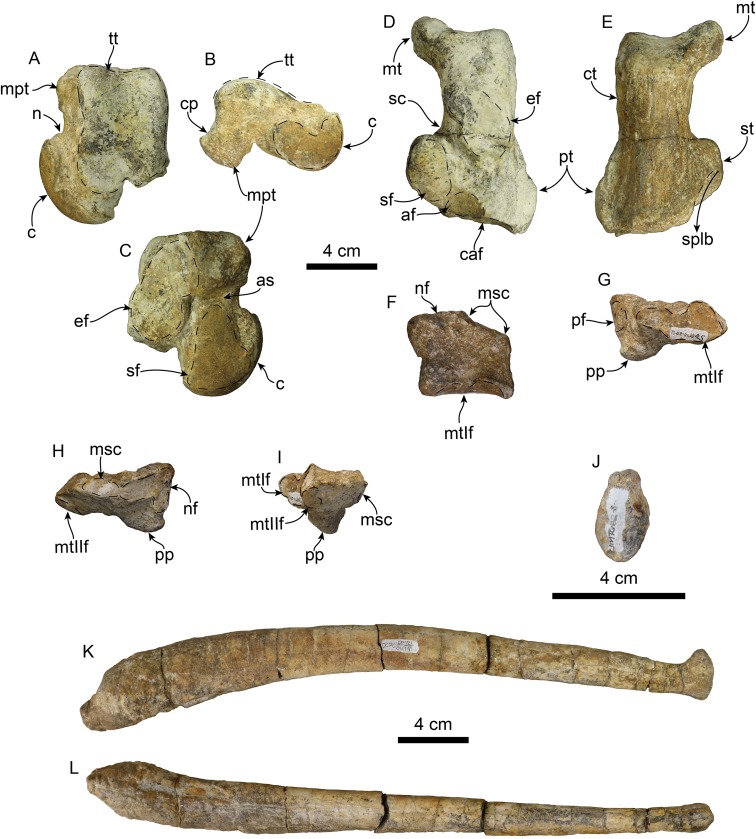
Hindlimb elements and baculum of Titanotaria orangensis n. gen. et sp. (OCPC 11141).Left astragualus in tibial (A), medial (B), and ventral (C) views; left calcaneum in dorsal (D), and plantar (E) views; left entocuneiform in dorsal (F), distal (G), proximal (H), and lateral (I), views; baculum in proximal (J), right lateral (I), and ventral (L) views. Abbreviations: af, accessory facet; astragalar sulcus; c, capitulum; caf, cuboid articular facet; cp, calcaneal process; ct, calcaneal tuber; ef, ectal facet; mpt, medial plantar tuberosity; msc, mesocuneiform facet; mt, medial tuberosity; mtIf, metatarsal I facet; n, neck; nf, navicular facet; pf, pisiform facet; pp, plantar process; pt, peroneal tubercle; sc, sulcus calcanei; sf, sustentacular facet; splb, sulcus for peroneus longus and peroneus brevis tendon; st, sustentaculum tali; tt, tibial trochlea.